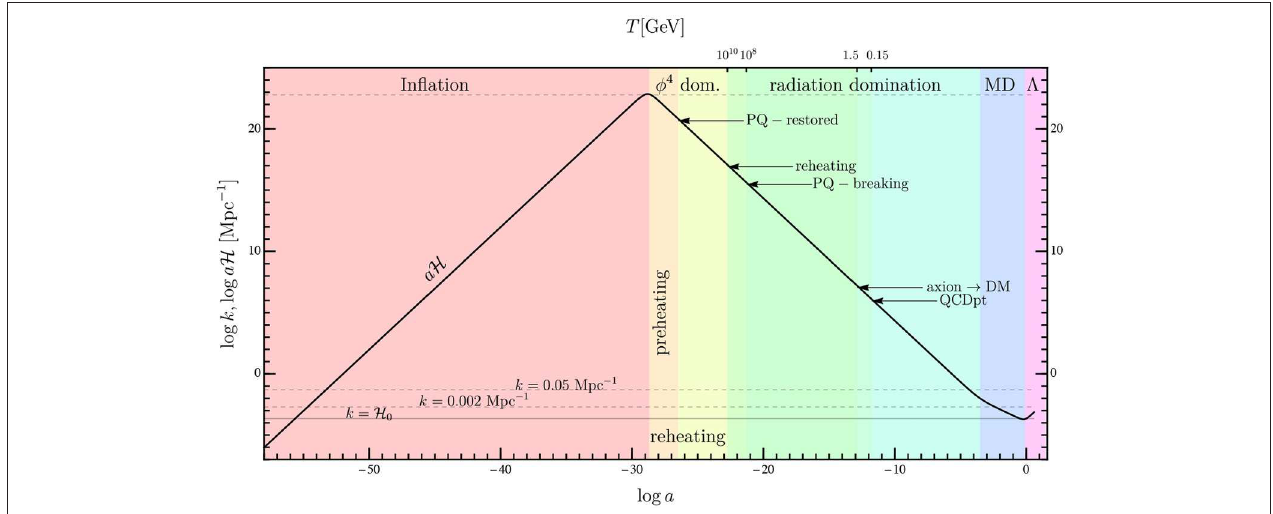
FIGURE 6 | Expansion and thermal history of the Universe in SMASH HHSI [taken and used with permission from Ballesteros et al.